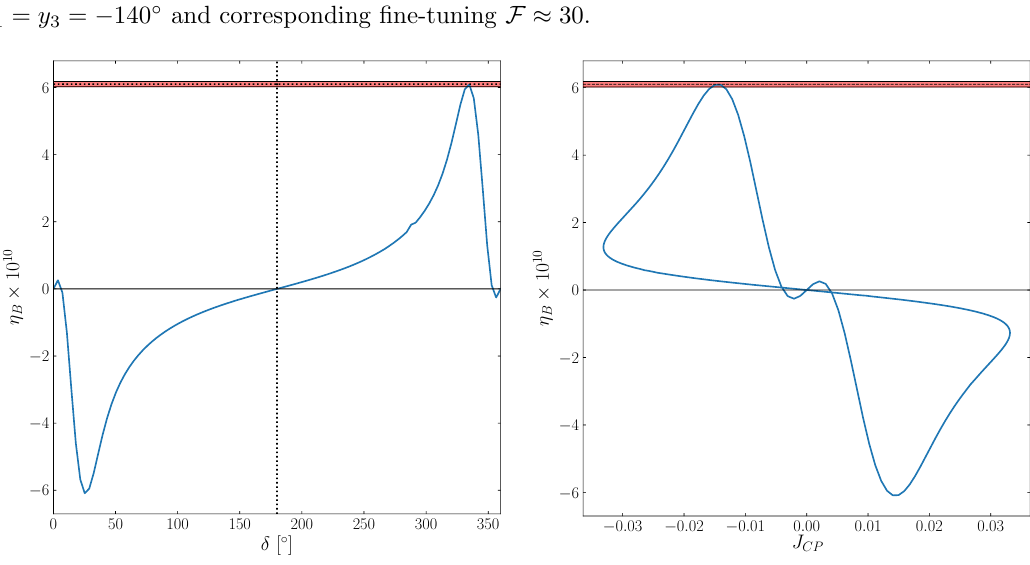
Figure 10 . Intermediate scale leptogenesis ( M 1 = 7 : 00 10 8 GeV), with CP violation provided (cid:2) solely by (cid:14) , with (cid:11) 21 = 180 (cid:14) and (cid:11) 31 = 0 (cid:14) . The red band indicates the 1 (cid:27) observed values for with the best-(cid:12)t value indicated by the horizontal black dotted line. Left: the (cid:12)nal baryon (cid:17) B CMB asymmetry as a function of (cid:14) with exact CP -invariance when (cid:14) = 0 (cid:14) and 180 (cid:14) (vertical black dotted line). Right: a parametric plot of (cid:17) B against J CP as (cid:14) is varied at intermediate scales ( M 1 = 7 : 00 10 8 GeV). See the text for further (cid:2)